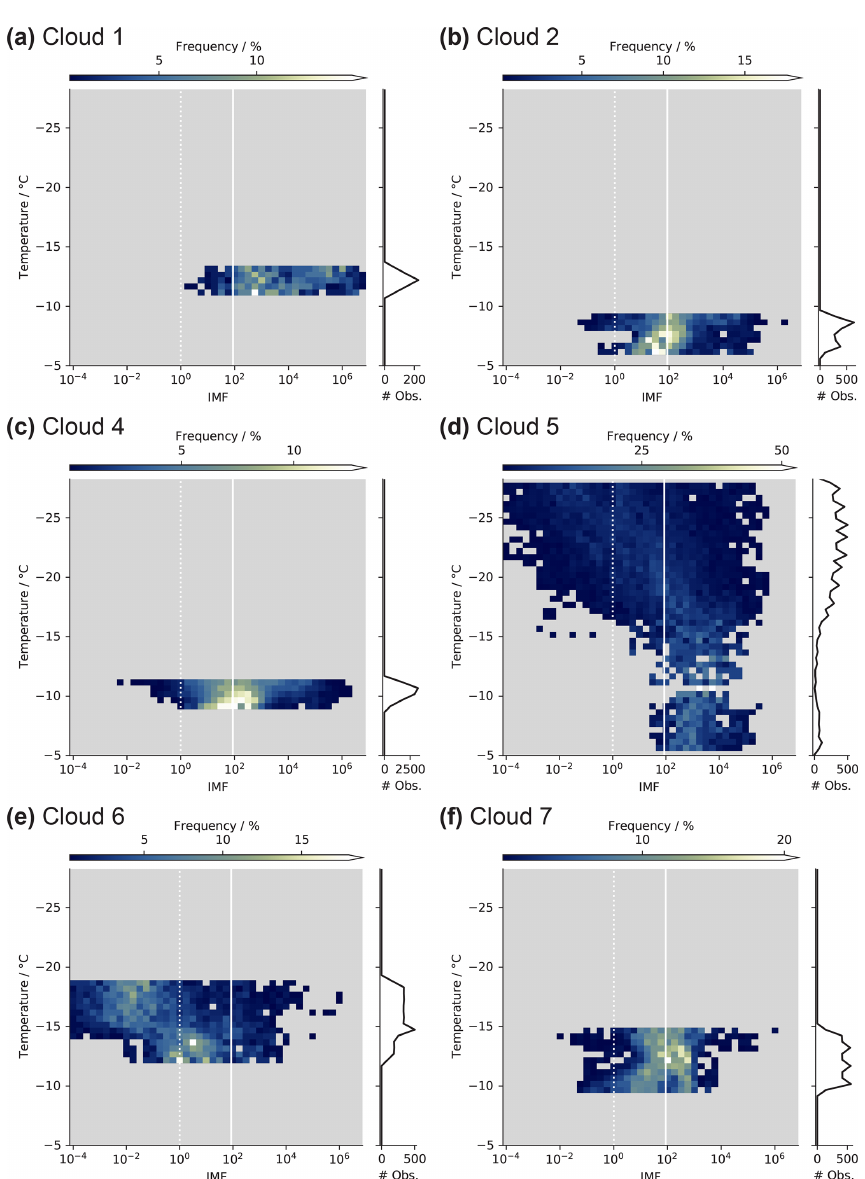
Figure E1. Frequency histogram of observed ice multiplication factors (IMFs) above cloud base with temperature per cloud. Frequencies are normalized to the number of observations (right axis) per temperature bin. Radar height was converted to temperature using data from the COSMO-1 analysis. Gray background indicates where no data were observed. The dashed white line indicates unity. The median IMF of all data is indicated in solid